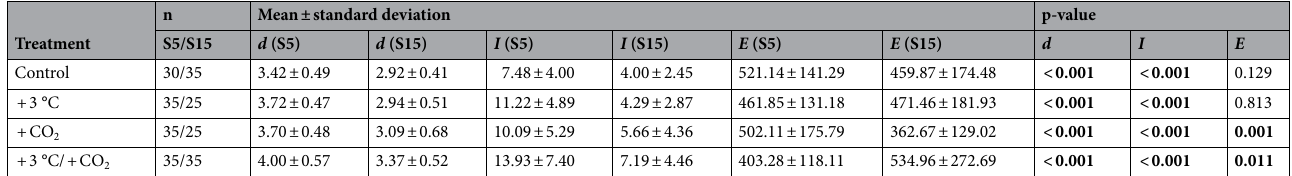
Table 2. Comparison of vegetation traits at 5 cm (S5) and 15 cm (S15) above the base along the Spartina stem per treatment. Mean values and standard deviation are given for d = diameter (mm), I = Second moment of area (mm 4 ) and E = Young’s bending modulus (N/mm 2 ) across all replicates per treatment with the given sample sizes n and p-values were derived with a 2 sample t-test. Differences that are statistically significant at the 5% level are displayed in